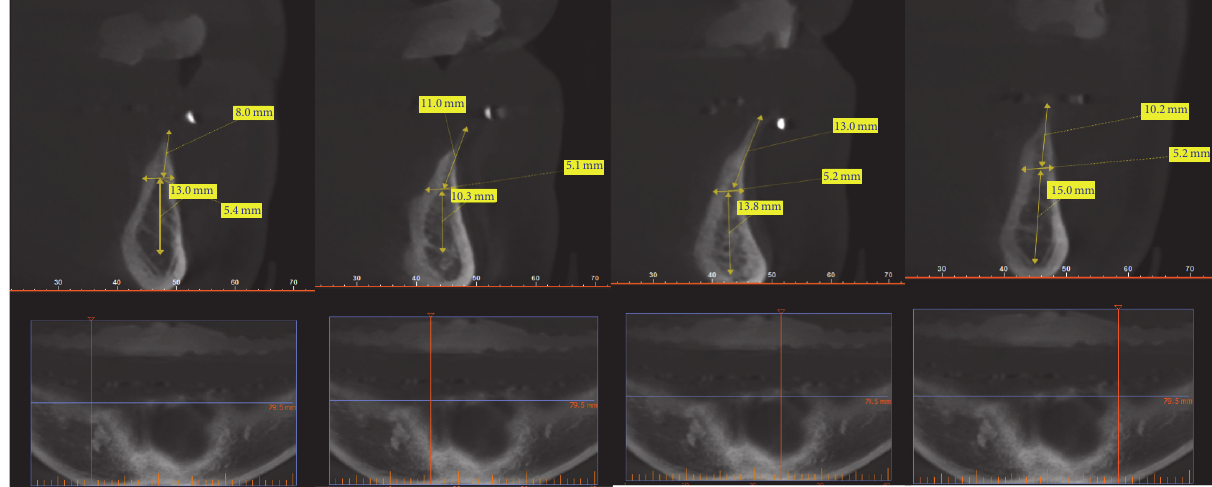
Figure 2: Cone beam computed tomography (CBCT) findings showing very thin coronal portion of the alveolar ridge.